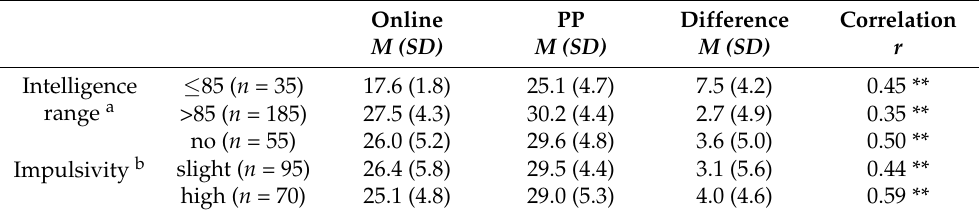
Table 4. Raw scores of the CFT 20-R online and PP versions for specific subgroups.